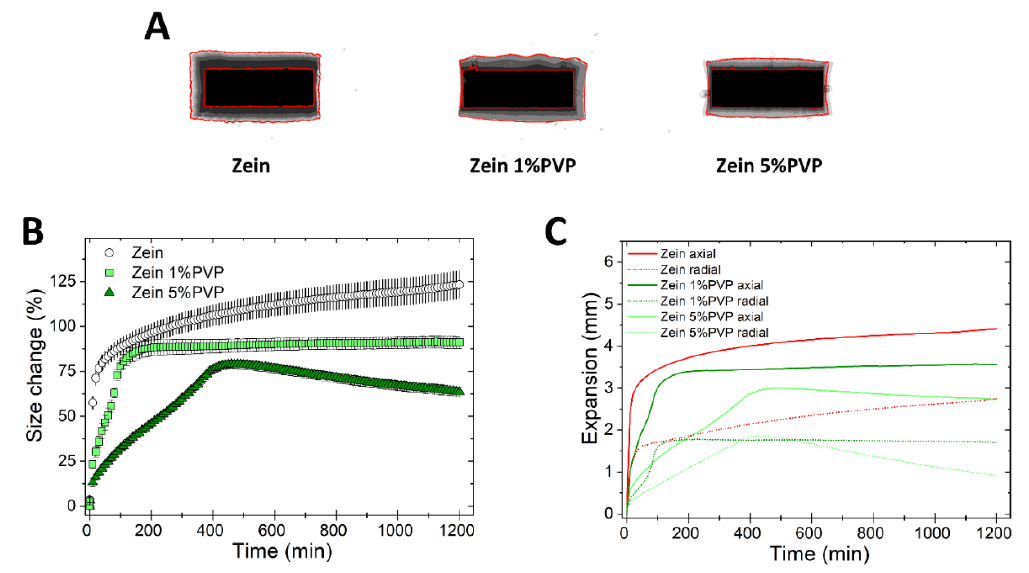
Figure 7. Swelling of tablets made of binary mixtures of zein and PVP (1% and 5% w / w ). ( A ) Sum of Z-stack of images. The two red lines are the outlines of the tablet at time 0 and at 20 h. ( B ) Swelling measured as the change of the projected area of tablets (mean ± SD, n = 3) as a function of time. ( C ) Axial and radial swelling of tablets (mean ± SD, n = 3) as a function of time.